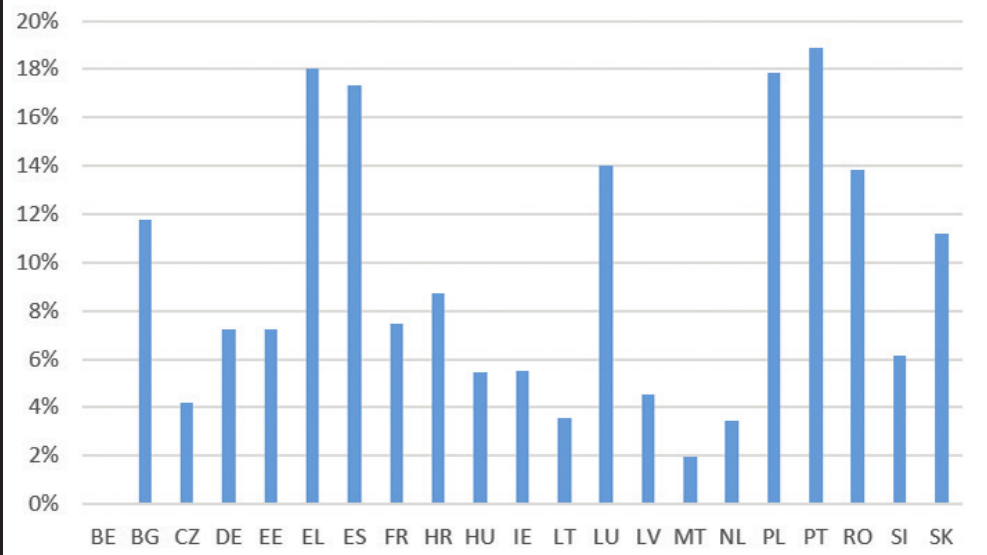
Figure A3 Share of workers earning (a wage close to) the SMW in the baseline scenario.